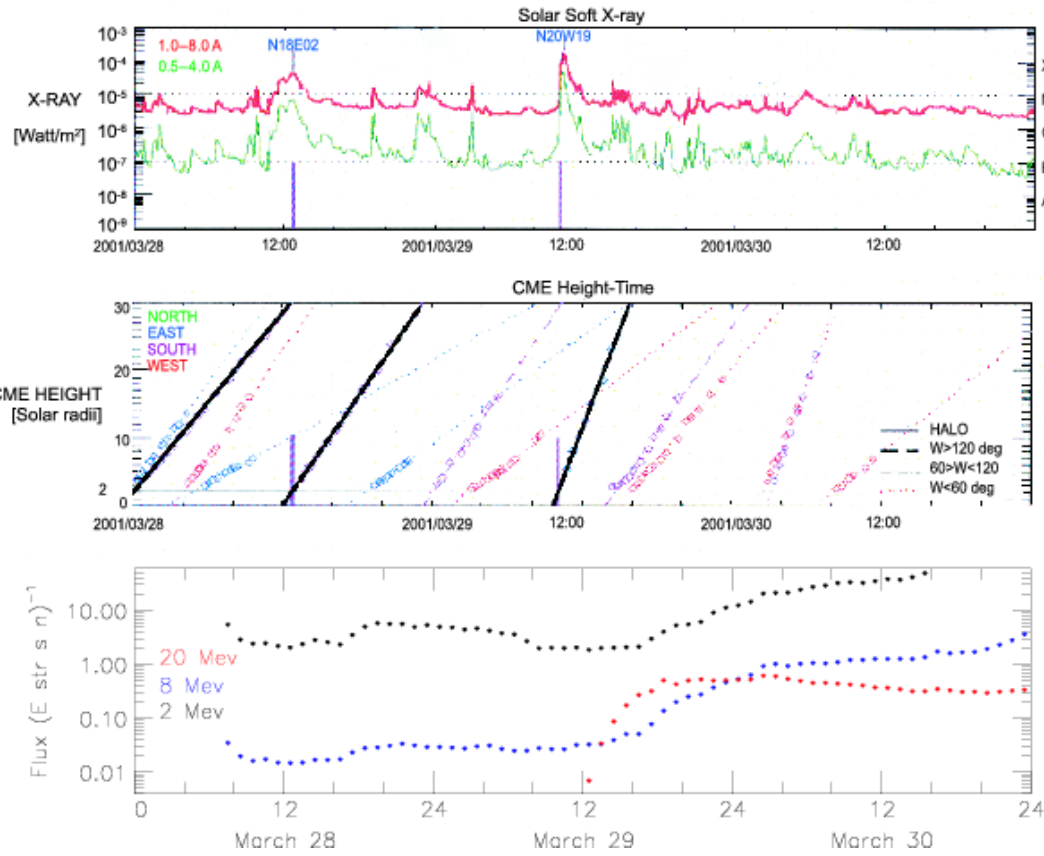
Fig. 8. Solar observations (top panels). Bottom panel: LEMT/EPACT measurements of high energy proton fluxes. A dispersional injection is seen starting at ∼ 12:00 UT, 29 March in the highest energy